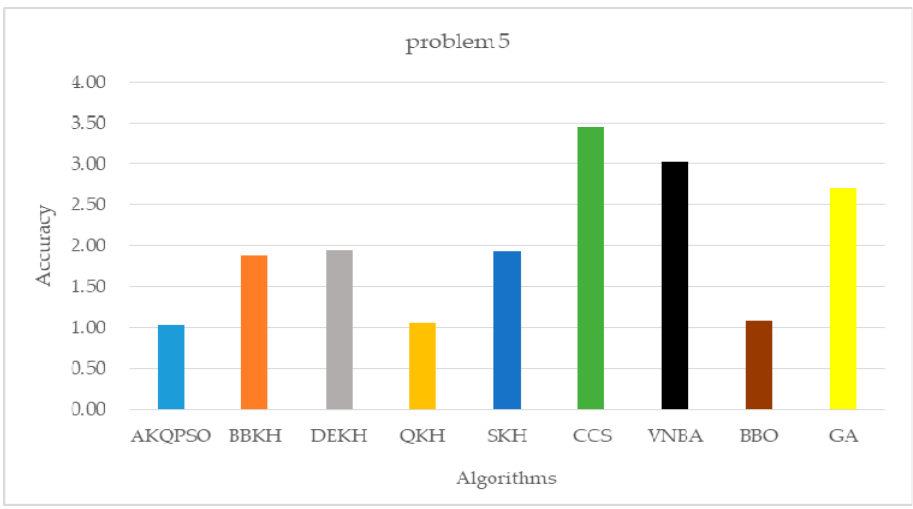
Figure 7. Accuracy of AKQPSO and other algorithms on problem 5: Griewangk’s function.